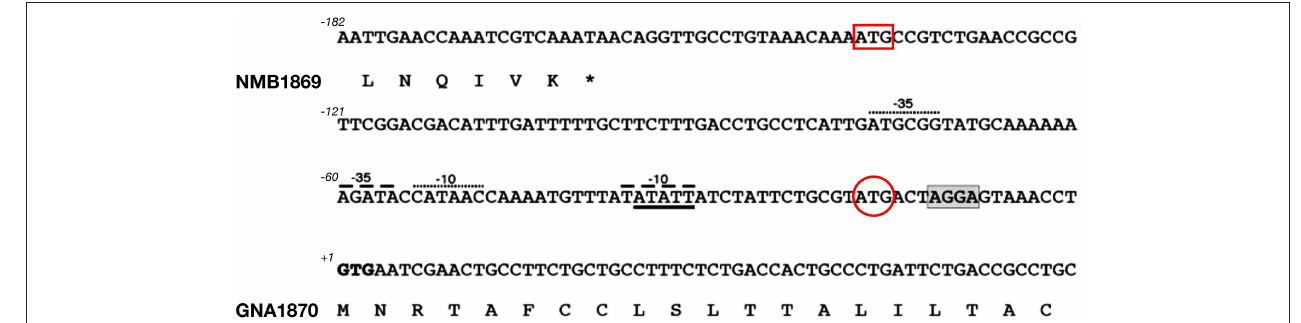
FIGURE 1 | Challenges in annotating correct start codons: the case of GNA1870. Nucleotide sequence of the intergenic region between nmb1869 and gna1870 genes in MenB strain MC58. The DNA sequence and deduced amino acid translation of the C-terminus of NMB1869 and N-terminal predicted lipoprotein signal peptide of GNA1870 are shown. The predicted start codons attributed automatically by softwares like Glimmer or GeneMark are indicated by a red box and a red circle, respectively. However, both ATG sites lacked correctly positioned ribosome binding site as well as − 10 and − 35 promoter elements. Most importantly, in both cases, amino acid translation would have resulted in an N-terminus of GNA1870 which lacked the features of a leader peptide, thus preventing the correct prediction of GNA1870 as a lipoprotein. Manual inspection identified the rare GTG start codon in position + 1 as the real translation initiation codon. The putative ribosome binding site is shaded and two possible − 10 and − 35 promoter elements are indicated by dashed lines and dots,